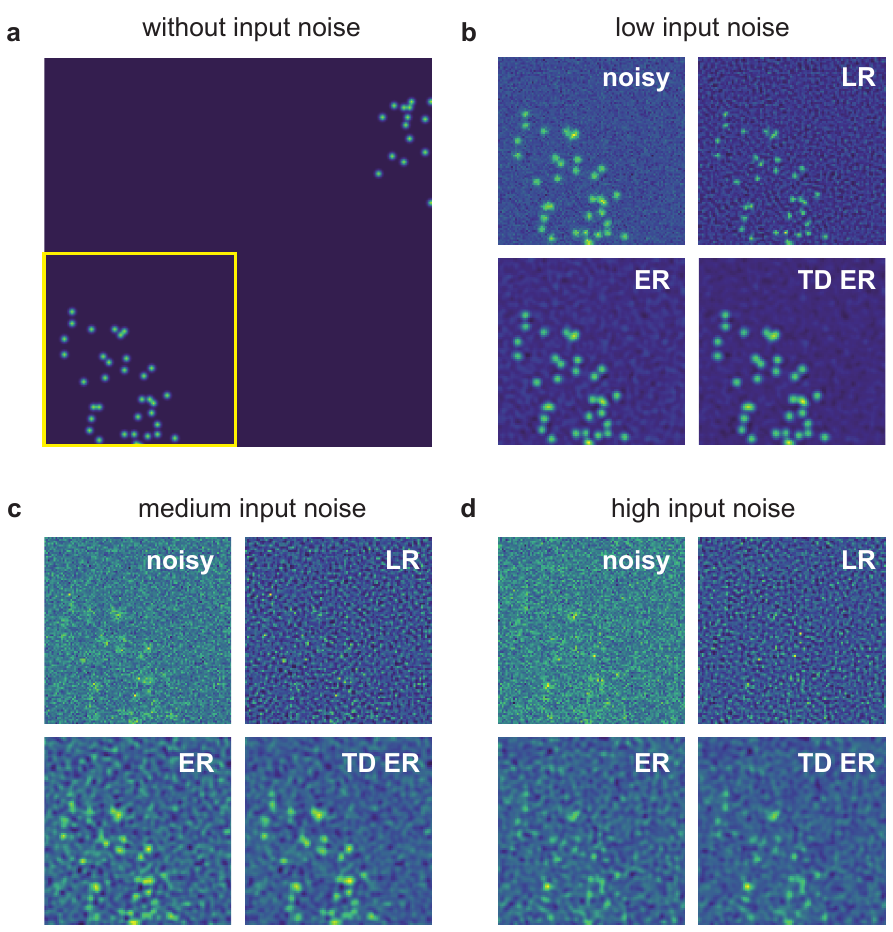
Figure 1. Example of synthetic data processed with the different deconvolution methods. ( a ) Sample frame of synthetic data without any added noise and before applying the PSF. The yellow box indicates the region of interest pictured in panels ( b – d ), which show input noisy images for various noise levels as well as image restoration results. The parameters for the entropy deconvolution are λ = 0.1 and (TD ER: λ = 0.1, λ T = 0.1) and ε = 0.001. LR: Lucy–Richardson deconvolution; ER: entropy regularization-based deconvolution (static); TD ER: time-dependent entropy regularization- based